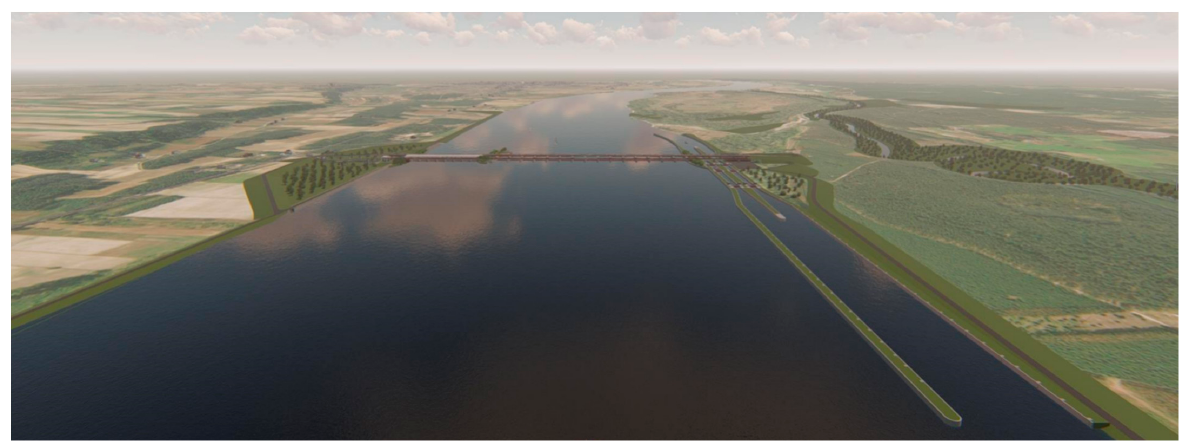
Figure 3. Conceptualization of the barrage on the Vistula River (Siarzewo Dam) [50].